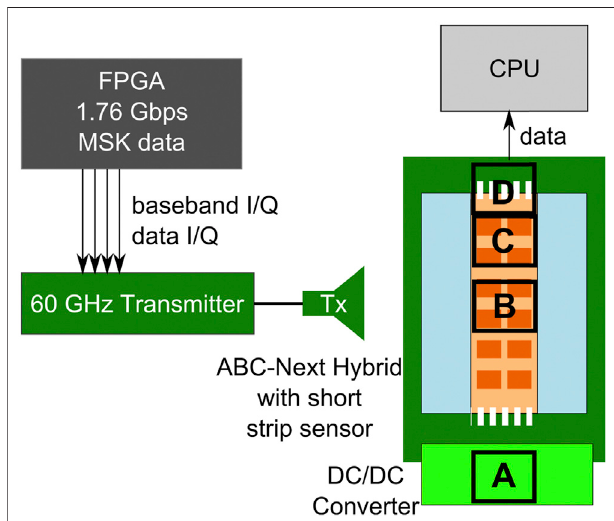
FIGURE 11 | Block diagram of the setup used for the irradiation test at Freiburg. A, B, C and D indicate different antenna positions used in the test. The 12 readout chips are illustrated as brown boxes on the orange readout hybrid [26].